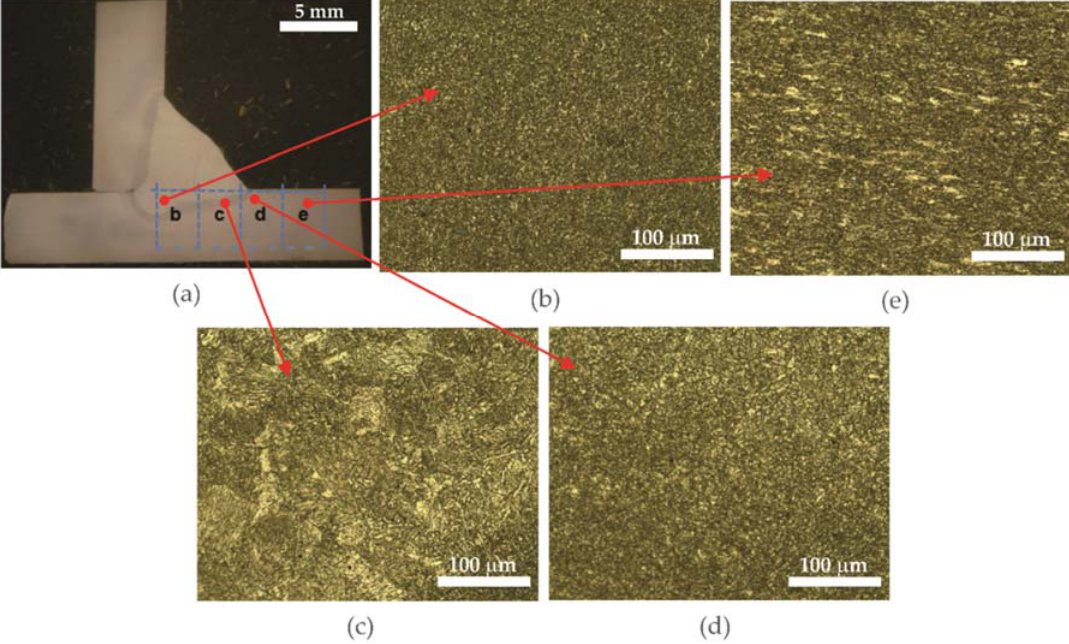
Figure 5. ( a ) Macrograph of the weld joint, ( b ) microstructure of the weld metal, ( c ) microstructure of the growth zone of the grain growth, ( d ) microstructure, of the refining zone of the grain, and ( e ) microstructure of the base metal.